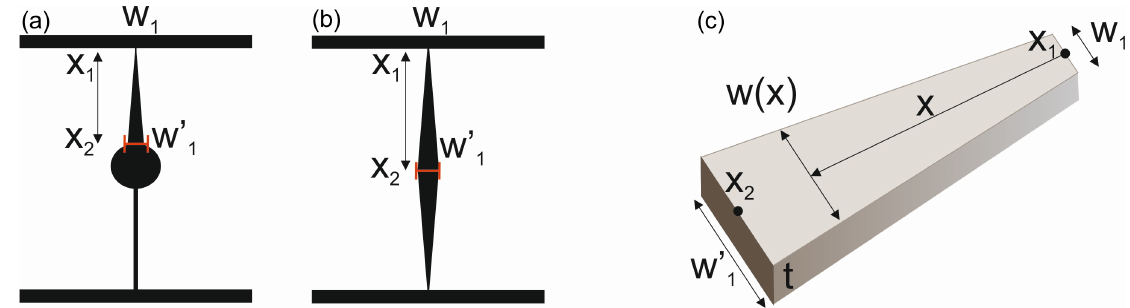
Figure 4. Depiction of the layout for a pyramid-shaped transmission electrode: ( a ) orthogonal and ( b ) voltage divider configuration. ( c ) Three-dimensional schematic the pyramid-shaped transmission